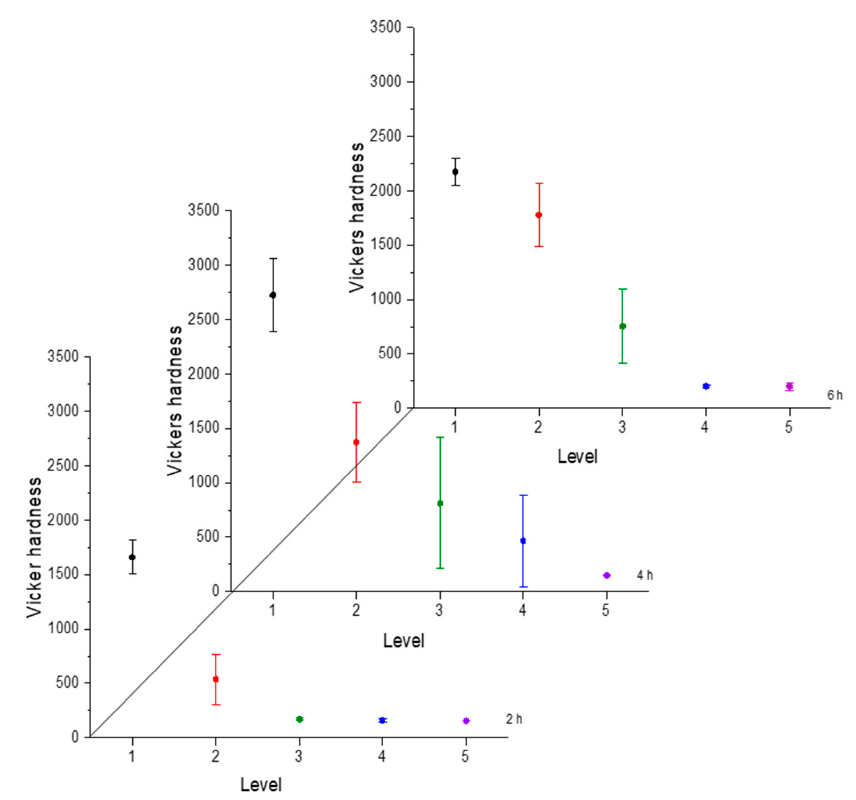
Figure 4. Microhardness evolution after boriding treatment at 850 °C.